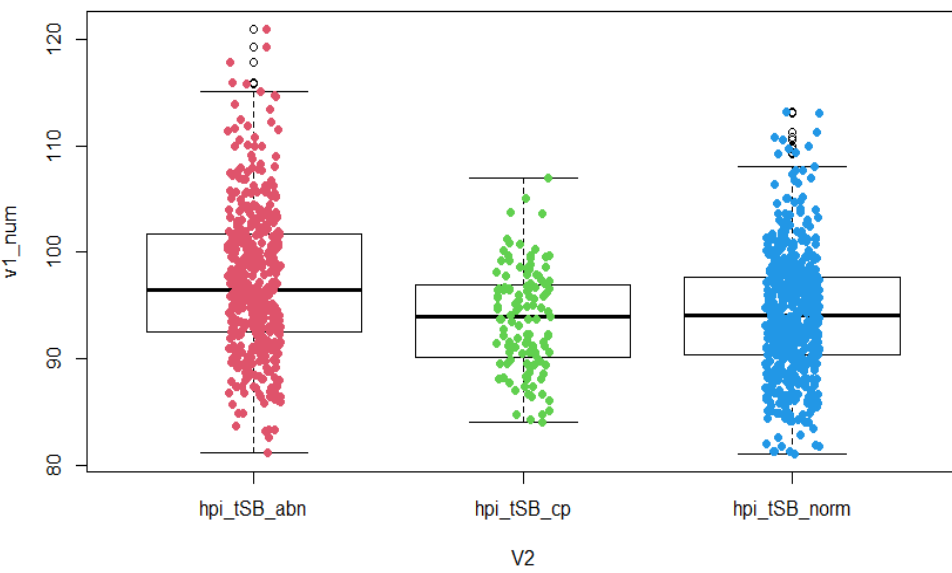
Figure 3. Time-lapse distribution—tSB in groups of PGT-A abnormal embryos, normal embryos with proven clinical pregnancy and normal embryos. Boxplot is categorized by groups: abn—PGT-A abnormal embryos, cp—PGT-A normal embryos with clinical pregnancy, norm—PGT-A normal embryos, hpi = hours post insemination, v1_num = numerically expressed time, v2 = identification of grouped variables containing the type of embryo. Table 2. Comparison of morphokinetic parameters in groups of PGT-A normal embryos with achieved clinical pregnancy and abnormal